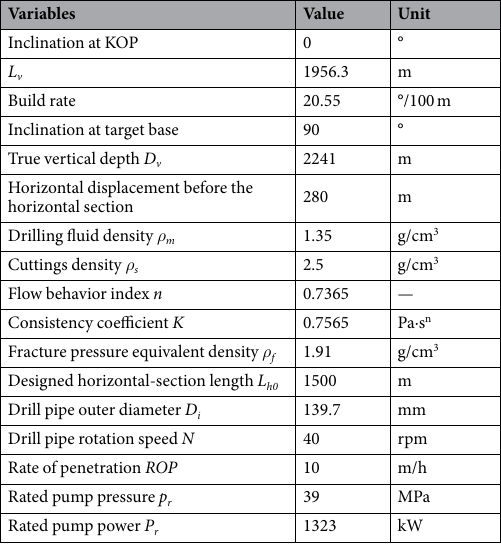
Table 2. List of input data for